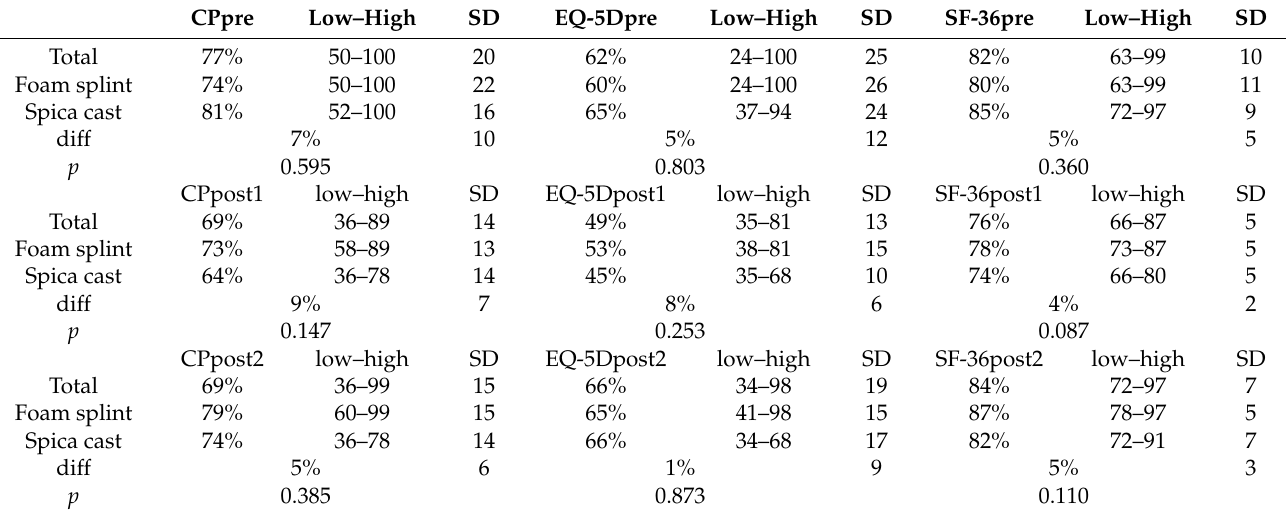
Table 3. Comparison of QOL scores at the three